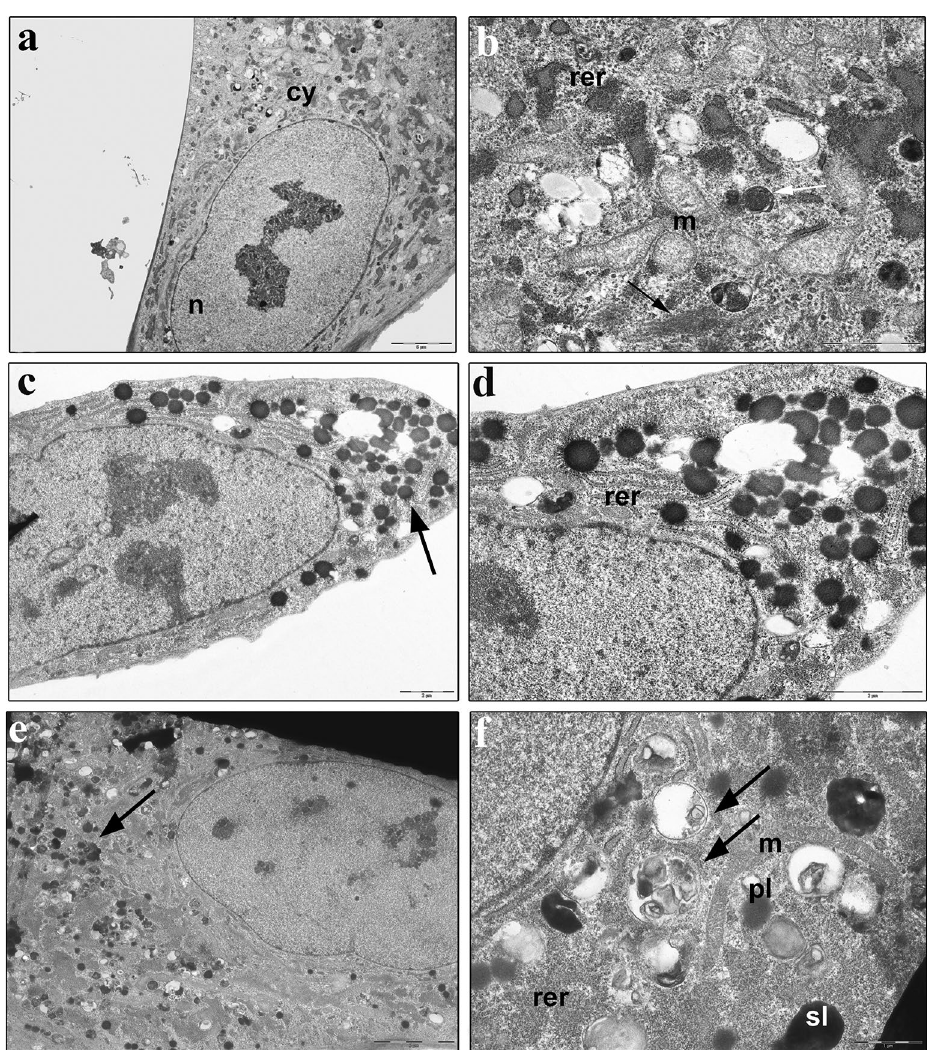
Figure 4. TEM ultrastructural analysis of hMSCs treated with morphine sulphate for eighteen days. ( a ) non- treated hMSCs show a polygonal morphology, with nucleus (n) and cytoplasm (cy) well preserved (bar: 5 µm). ( b ) Detail of cytoplasm showing long shape mitochondria (m), rough endoplasmic reticulum (rer), Golgi complex (black arrow) and primary lysosomes (white arrow) (bar: 2 µm); ( c ) hMSCs exposed to 0.4 mM of morphine sulphate. Several lysosomes (black arrow) are observed in the cytoplasm (bar: 2 µm); ( d ) detail of cytoplasm showing lysosomes, some vesicles and well developed RER (rer) (bar: 2 µm); ( e ) low magnification image of hMSCs exposed to 1 mM of morphine sulphate. Several lysosomes (black arrow), and vesicles are still observed in the cytoplasm (bar: 5 µm; ( f ) detail of cytoplasm showing several primary (pl) and secondary lysosomes (sl), autophagic vesicles (black arrows) and enlarged RER (rer) are detected. Long shape and well- preserved mitochondria (m) are easily observed (bar: 1